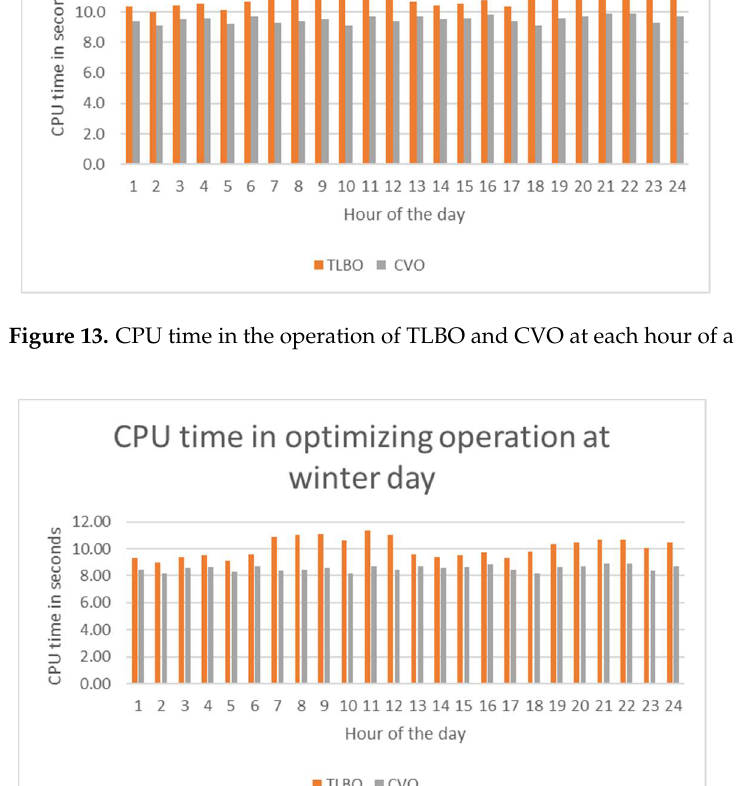
Figure 14. CPU time in the operation of TLBO and CVO at each hour of a winter day.